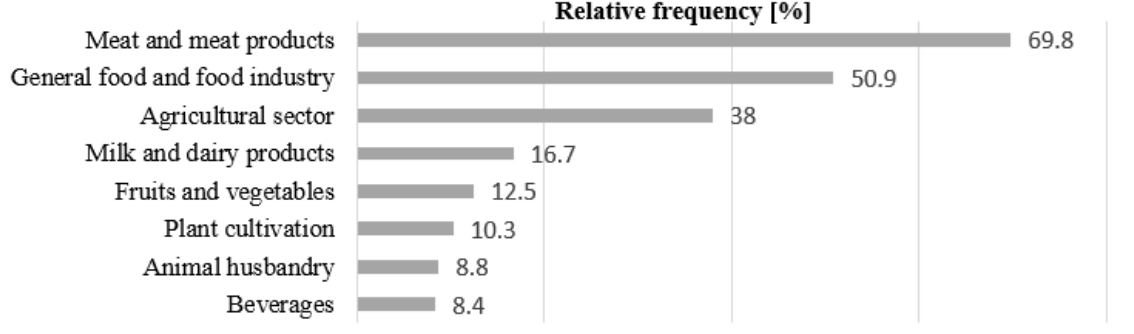
Figure 2. Relative frequencies of industry-relevant keywords differentiated by media type. Source: own calculations.